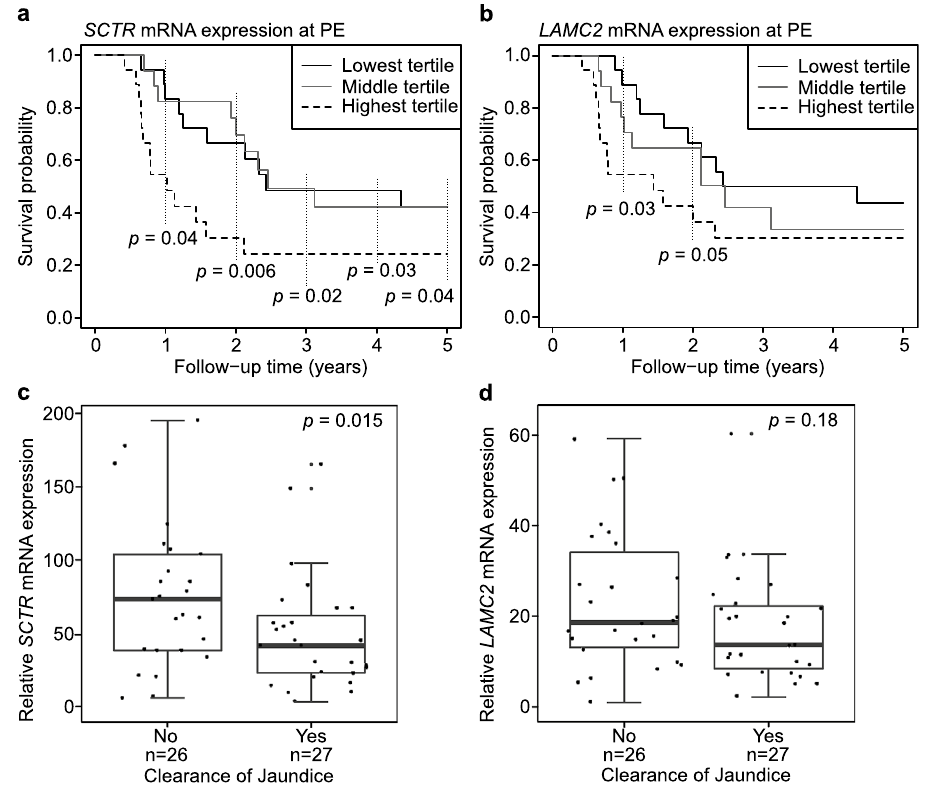
Figure 2. Portoenterostomy (PE) outcomes according to secretin receptor ( SCTR ) and laminin subunit gamma-2 ( LAMC2 ) expression. Kaplan–Meier survival curves for native liver survival according to tertiles of mRNA liver expression in ( a ) SCTR and ( b ) LAMC2 at PE (n = 53). Significant p-values are shown separately for each follow-up year. Expression of ( c ) SCTR and ( d ) LAMC2 according to clearance of jaundice following